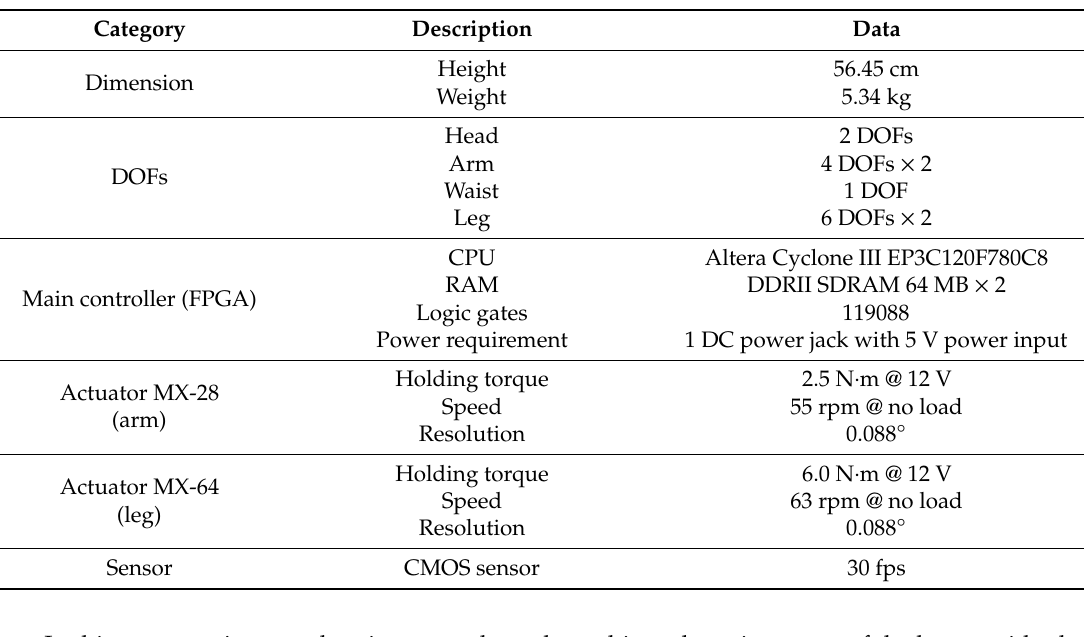
Table 1. Specifications of the small-sized humanoid robot.